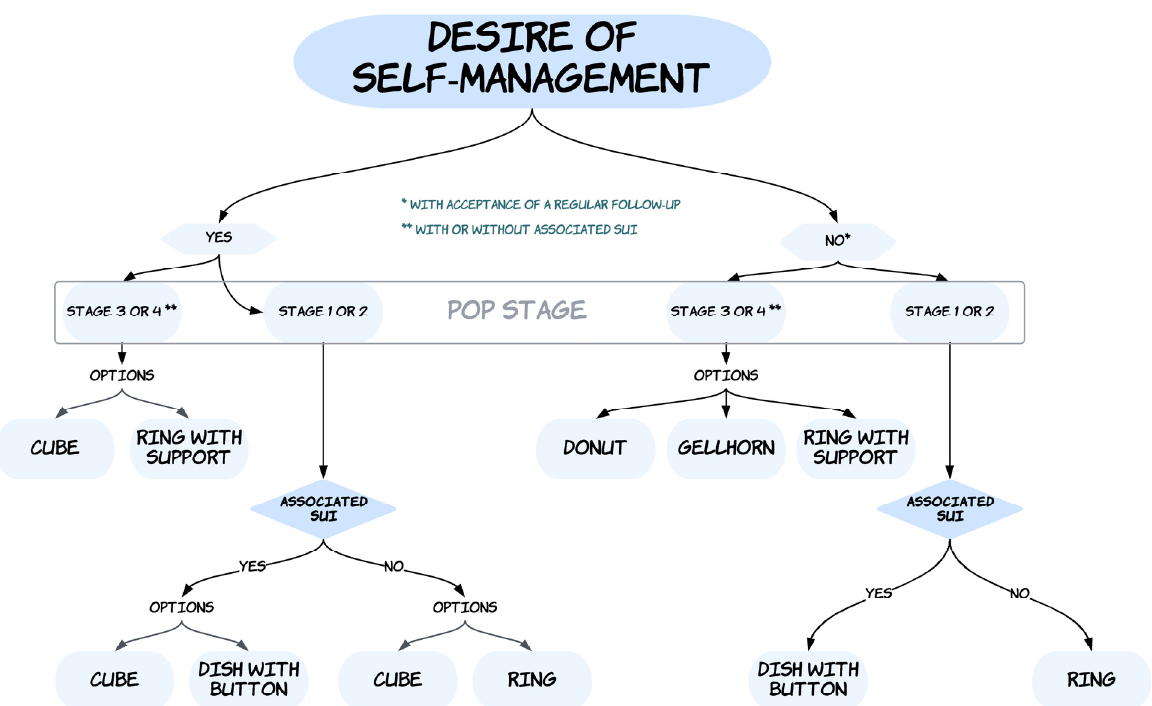
Figure 1. Algorithm for choice of pessary. Abbreviations: POP, pelvic organ prolapse; USI, urinary stress incontinence.